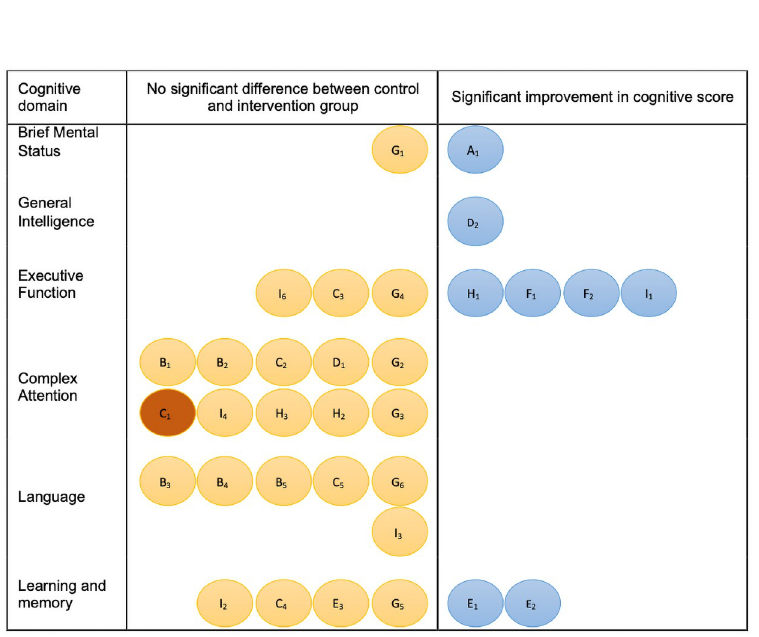
Fig 2. Representation of cognitive tests divided into cognitive domains for studies with control group. A: Mulrow 1990